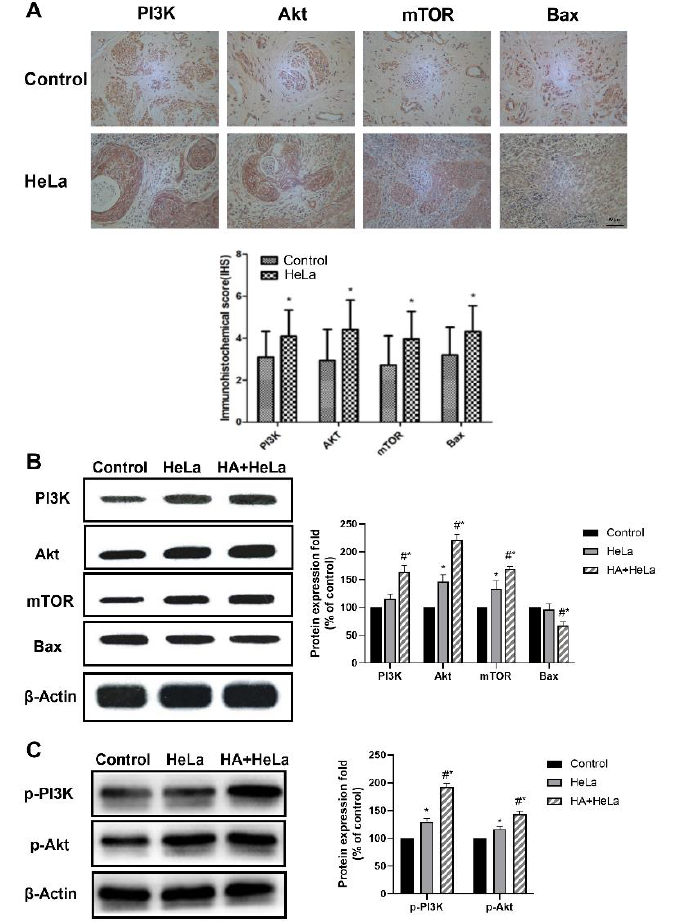
Figure 3. Histamine induced apoptosis via inhibition of the PI3K / Akt / mTOR signaling pathway in HeLa cells. The PI3K / Akt / mTOR signaling pathway was activated by the treatment of histamine. ( A ) Immunohistochemistry detection of PI3K, Akt, mTOR and Bax expression level in the cervical tissue of the control group and HeLa group. ( B ) Western blot analysis of PI3K, Akt, mTOR and Bax expression level from respective tumor tissues. The antibodies used in this experiment were PI3K (ABP52199), Akt (ABM40276), mTOR (ABP51866) and Bax (ABP55948). ( C ) Western blot analysis of p-PI3K and p-AKT expression level from respective tumor tissues. The antibodies used in this experiment were p-PI3K(ab182651) and p-Akt(ab81283). The locus of p-PI3K and p-Akt was Y607 and S473 respectively. The results are expressed as a percentage of control, which is set at 100%. Data are presented as the mean ± SEM of at least three independent experiments. * p < 0.05 versus the control group, # p < 0.05 versus the HeLa group.